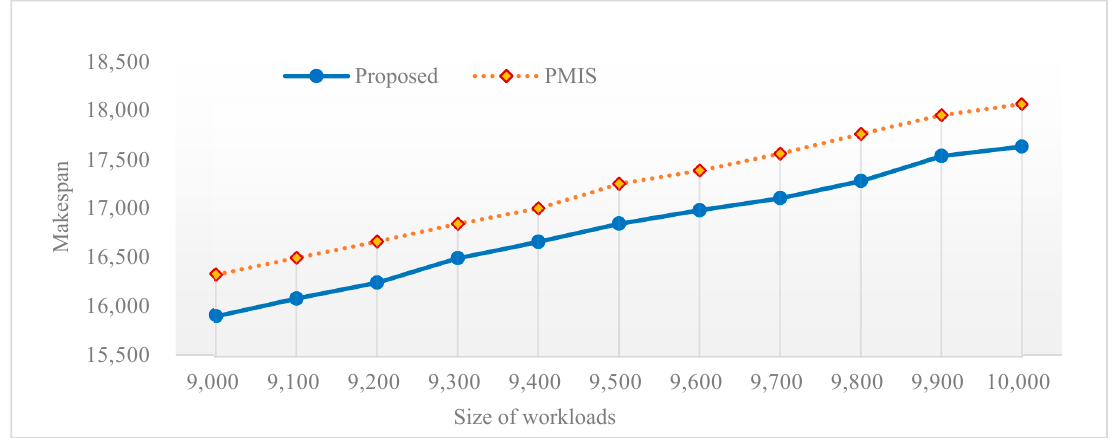
Figure 3. Makespan versus the size of workloads.